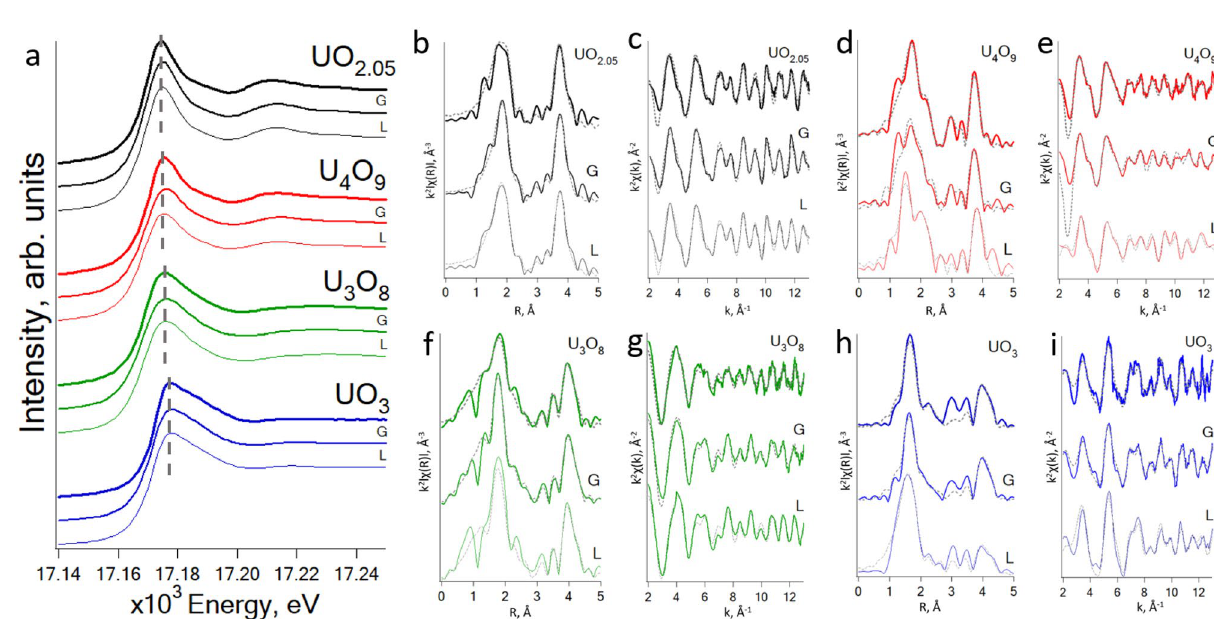
Figure 3. ( a ) XANES spectra at the U L3-edge for uranium oxides in various oxidation states. ( b , c ) EXAFS spectra at the U L3-edge for uranium oxides in various oxidation states and their Fourier transforms. Solid lines are for experimental data, dotted lines are for fits.